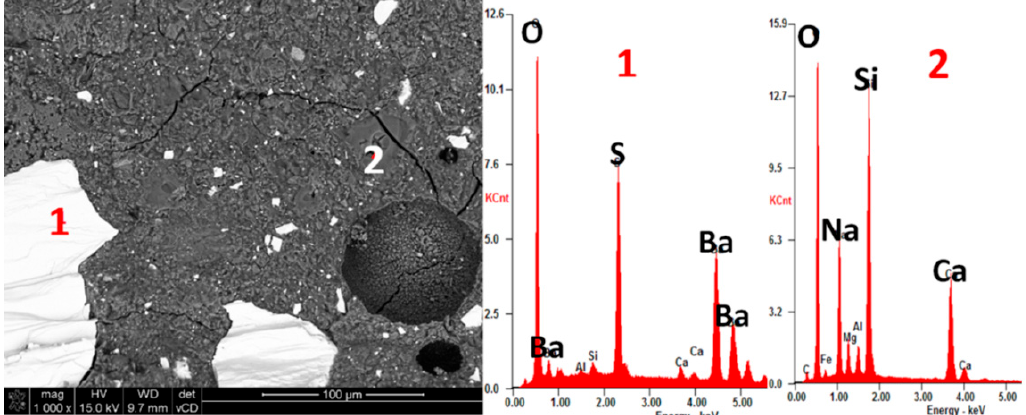
Figure 8. SEM microphotograph with EDX analysis showing the presence of (2) Si-Ca-Na gel in mortar bar with (1) barite aggregate B2 after 28 days of exposure in 80 °C and 1 M NaOH.